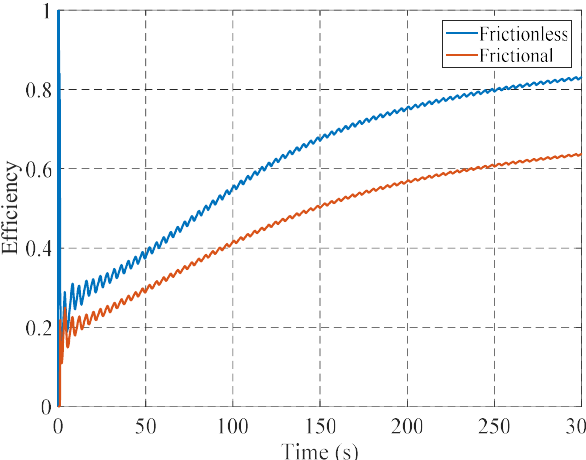
Figure 14. The efficiency of hydraulic PTO under frictionless and friction is 0.82 and 0.58 respectively.